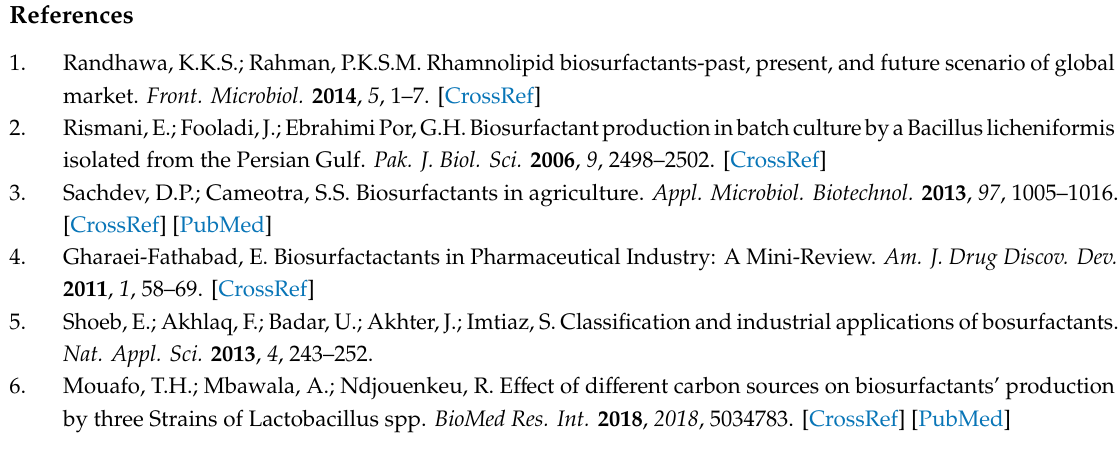
Supplementary Materials: The following are available online, Table S1: Analysis of variance (ANOVA) of the regression model from the PBD for medium components contribution to (a) cell growth and (b) maximum biosurfactant productivity, Table S2: Analysis of variance (ANOVA) of the regression model from the CCD for medium components contribution to a) cell growth and b) biosurfactant productivity in uncoded